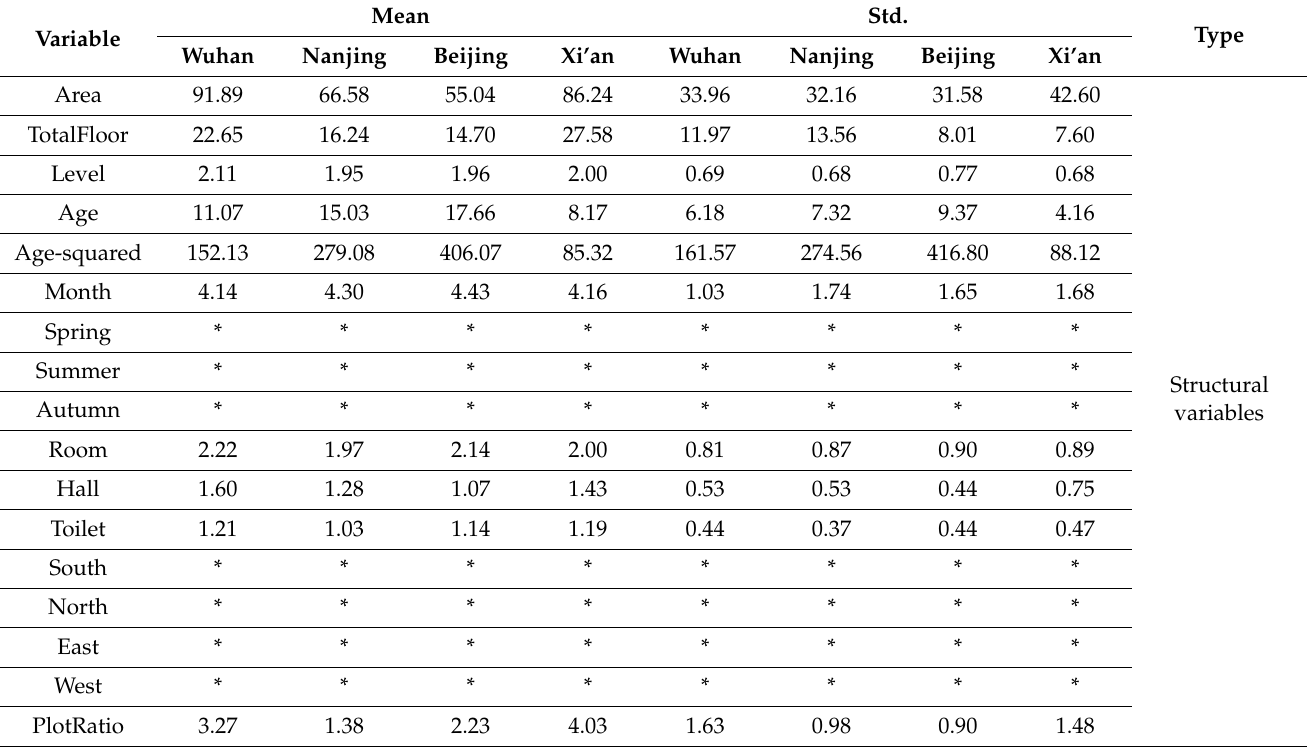
Table A1. The statistics of the rental house price data and relevant attributes of the study